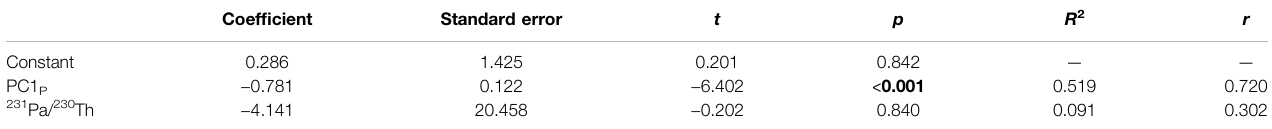
TABLE 2 | Results from a multiple linear regression between summarized paleo-productivity (PC1 P ; fi rst axis of a principal component analysis including all correlatable productivity proxies) and bottom water velocity 231 Pa/ 230 Th and summarized dissolution ( fi rst axis of a principal component analysis including all dissolution proxies) as dependent variable for sediment core SAT-048A from the South Atlantic. p -values signi fi cant at α = 0.05 are indicated in bold.